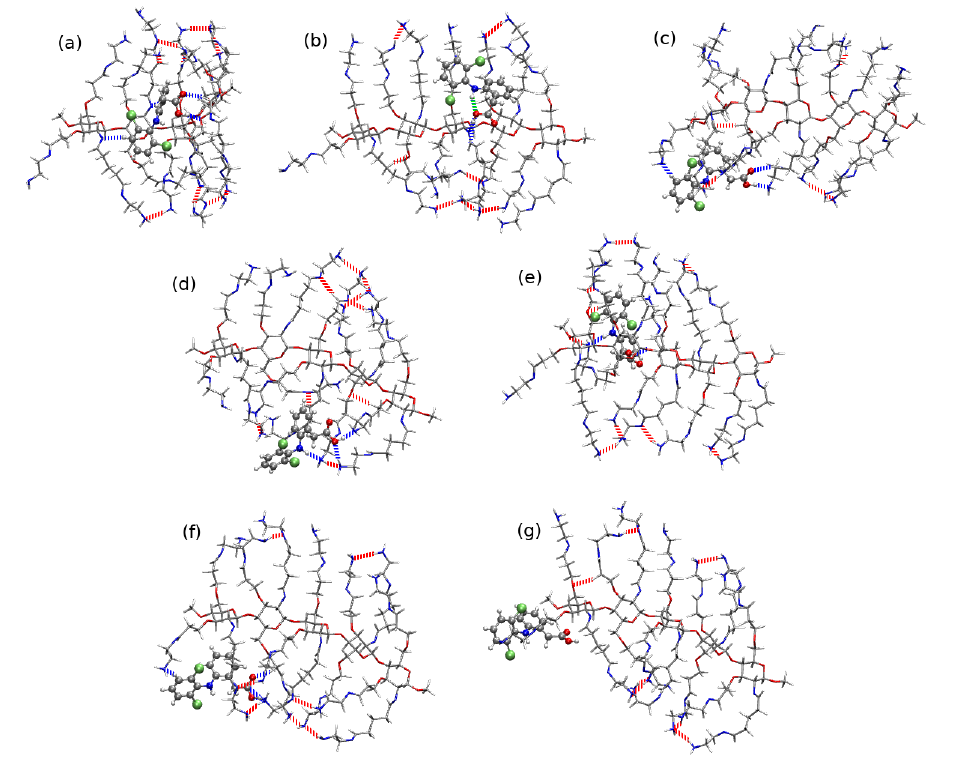
Figure 16. B97-D3/6-311++G(d,p) interaction in most attractive structures of CS5(NH 2 ) 3 :DFH, namely: ( a ) CS5(NH 2 ) 3 :DFH 10 , ( b ) CS5(NH 2 ) 3 :DFH 20 , ( c ) CS5(NH 2 ) 3 :DFH 12 , ( d ) CS5(NH 2 ) 3 :DFH 11 , ( e ) CS5(NH 2 ) 3 :DFH 18 , ( f ) CS5(NH 2 ) 3 :DFH 13-PT and the weakest complex, ( g ) CS5(NH 2 ) 3 :DFH